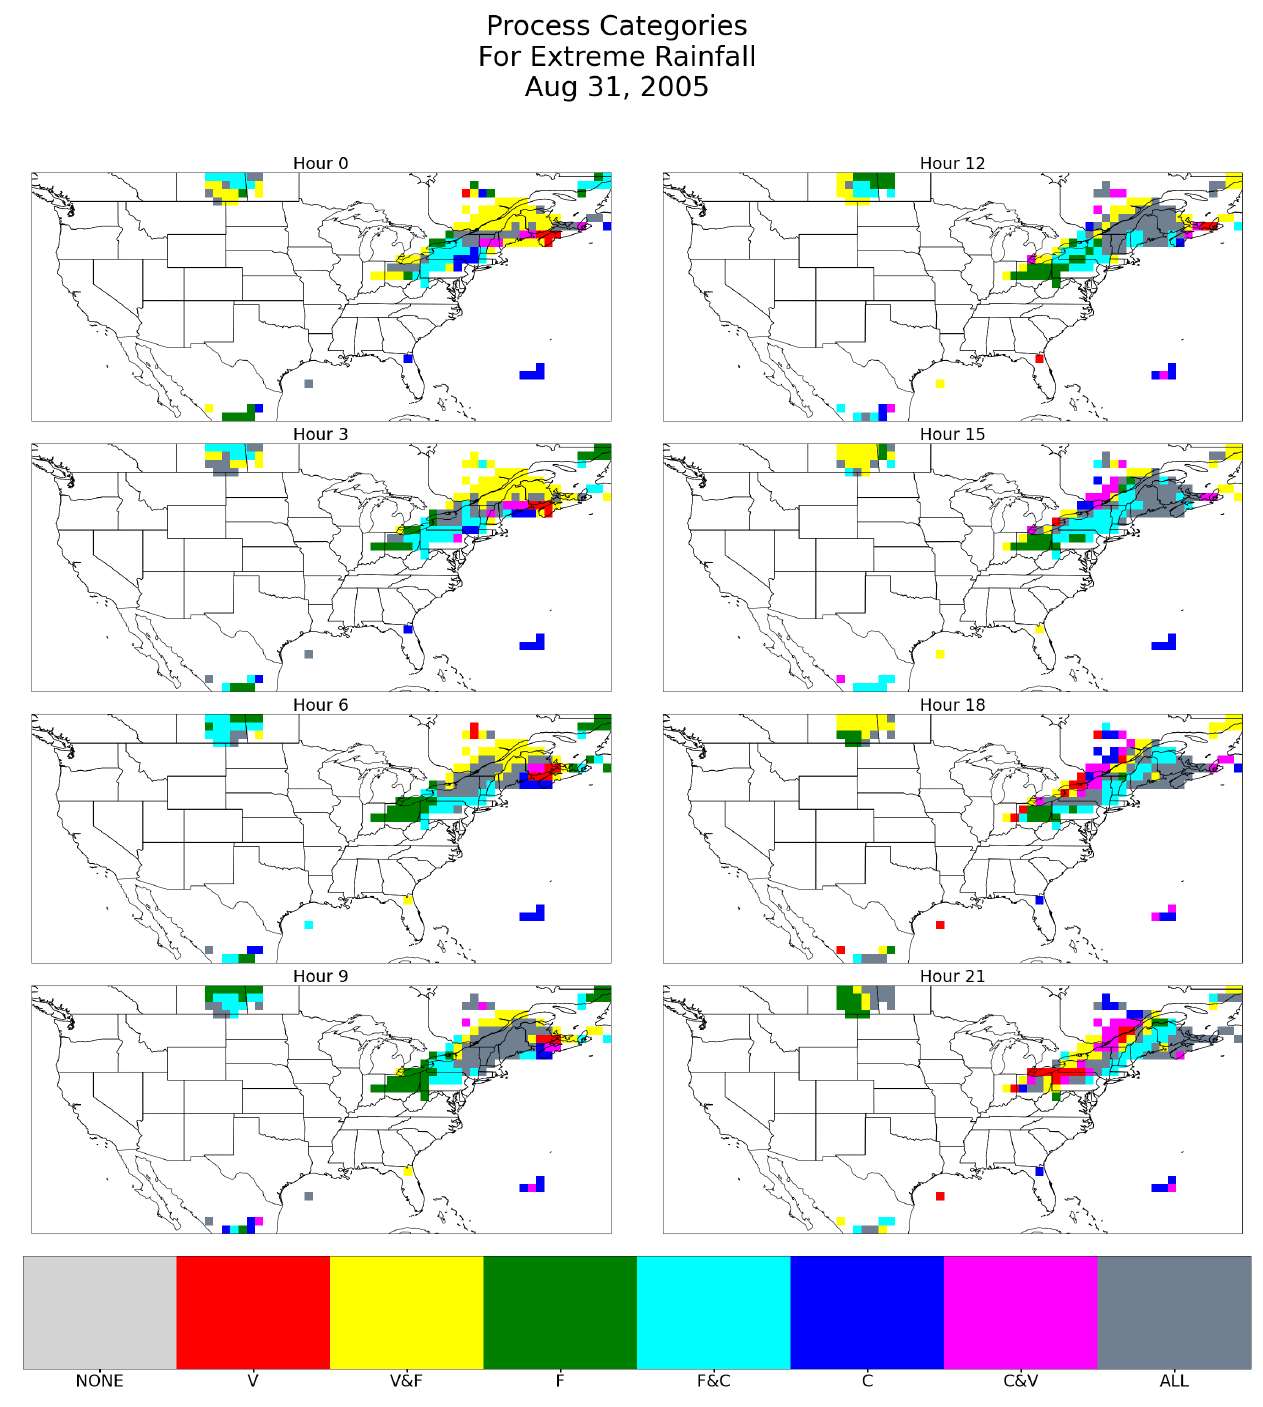
Figure 10. Plot of the process category for each grid point with precipitation > 12.5 mm during the day of 31 August 2005. The categories are labeled as follows: V—Vorticity, F—Frontal, C—Convection. The area of interest is the largest connected area of colored dots, classified as a frontal extreme by Kunkel [1]. All times are